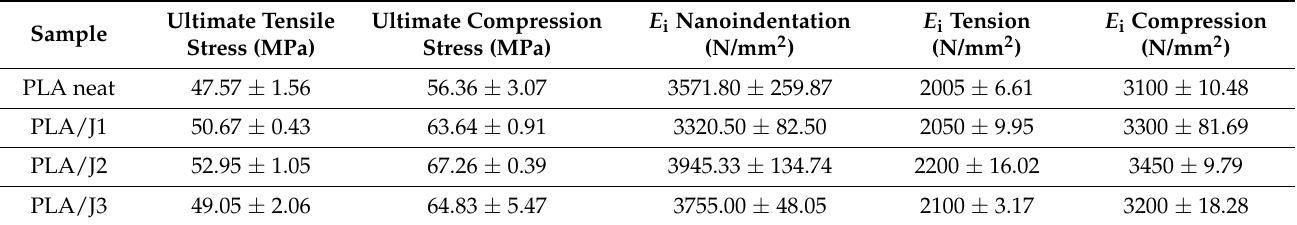
Figure 7. Representative stress–strain curves for ( a ) tensile and ( b ) compression specimens of neat PLA and PLA/J. Table 4 presents the summary of the results of the maximum stresses of the tensile and compression testing, and the comparison of the elastic moduli of nanoindentation, tension, and compression tests of neat PLA and PLA/J specimens. The mechanical testing of four specimens demonstrated that the addition of the multi-functional epoxide Joncryl ADR- 4400 improved the mechanical behavior of PLA. Although a decrease in the mechanical properties of PLA/J3 could be noticed, which might be due to a high concentration of chain extender in PLA. Table 4. Comparison of the ultimate stresses of tensile and compression testing and the comparison of the elastic moduli of nanoindentation, tension, and compression testing of neat PLA and PLA/J